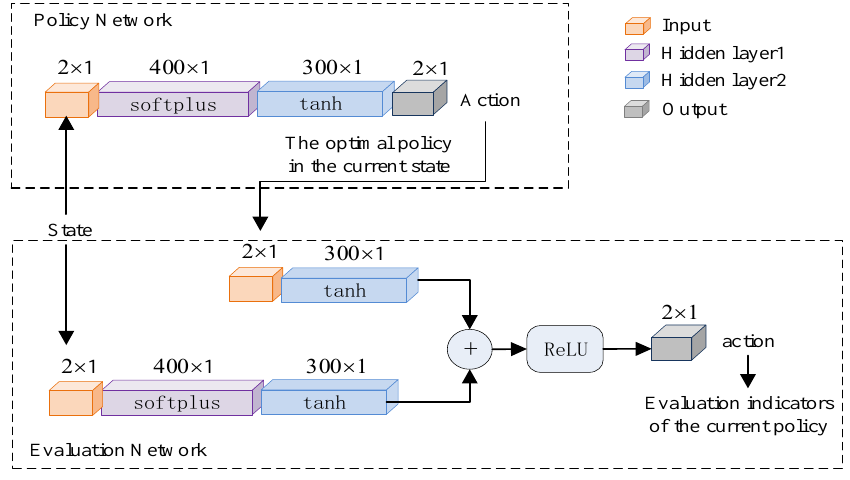
Figure 7. Design of strategy network and evaluation network